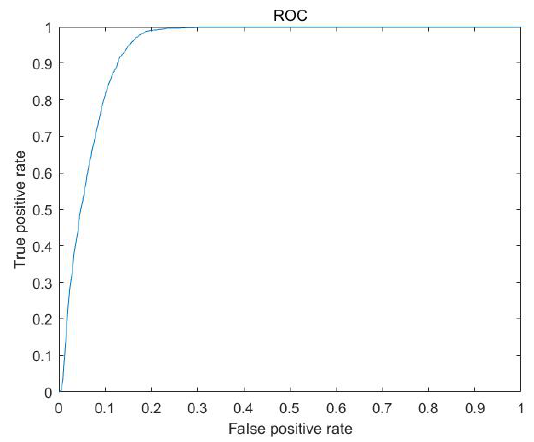
Figure 9. Receiver operating characteristic (ROC) rate of the susceptibility results.